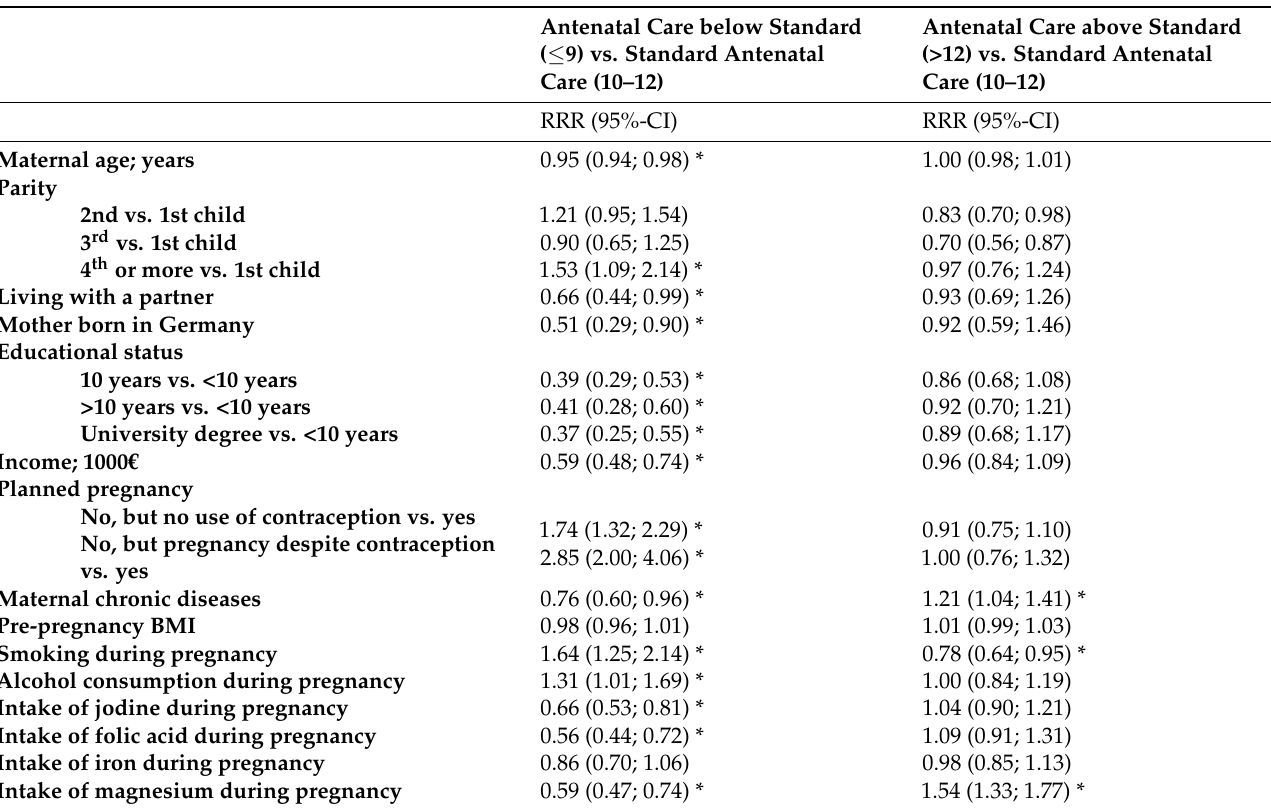
calculated using a multinominal regression model adjusted for gestational age at birth. Table 4. Association of selected variables with antenatal care behavior adjusted for gestational age at birth. Antenatal Care below Standard ( ≤ 9) vs. Standard Antenatal Care